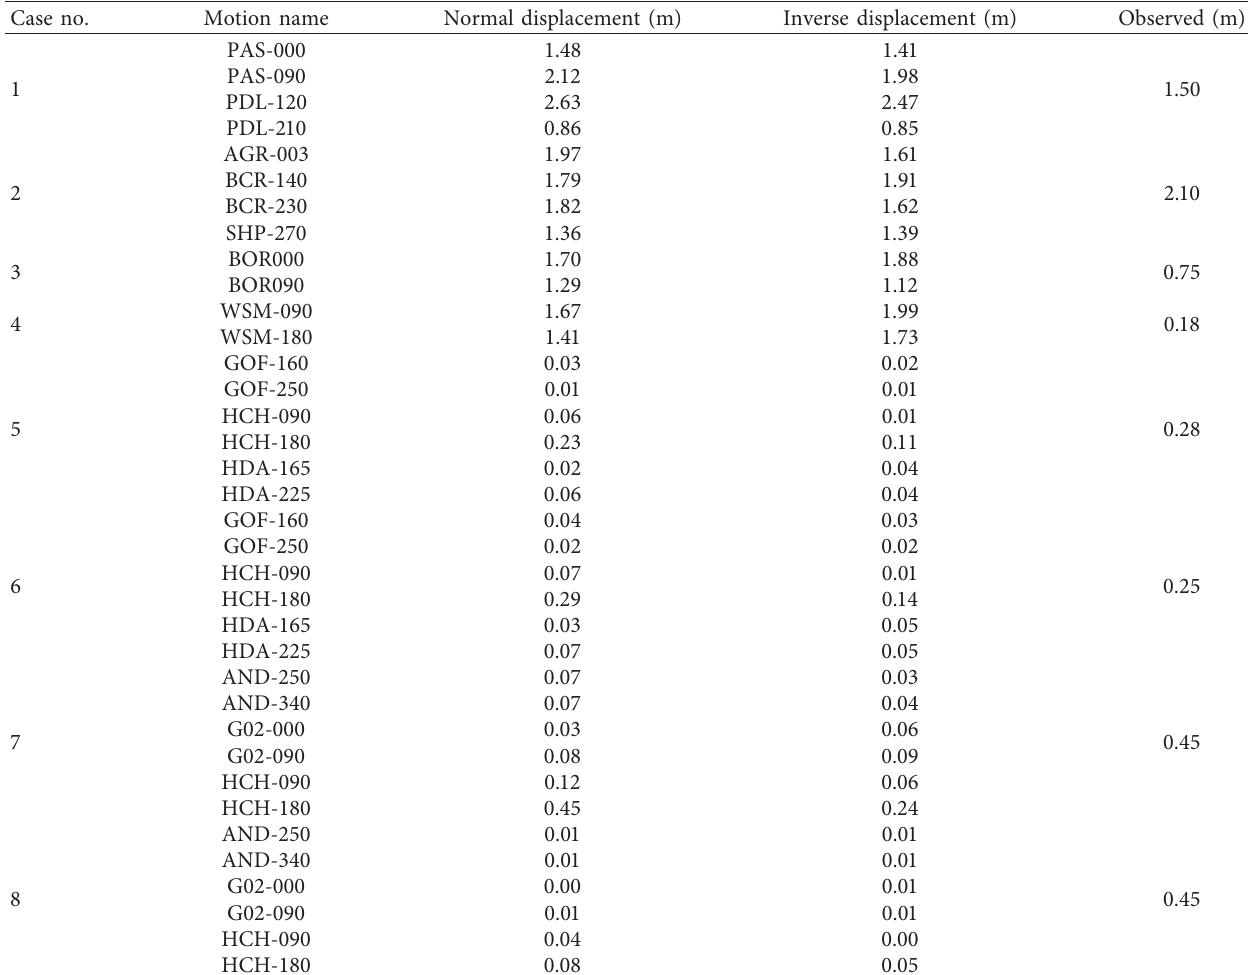
Table 4: Summarization of calculated lateral